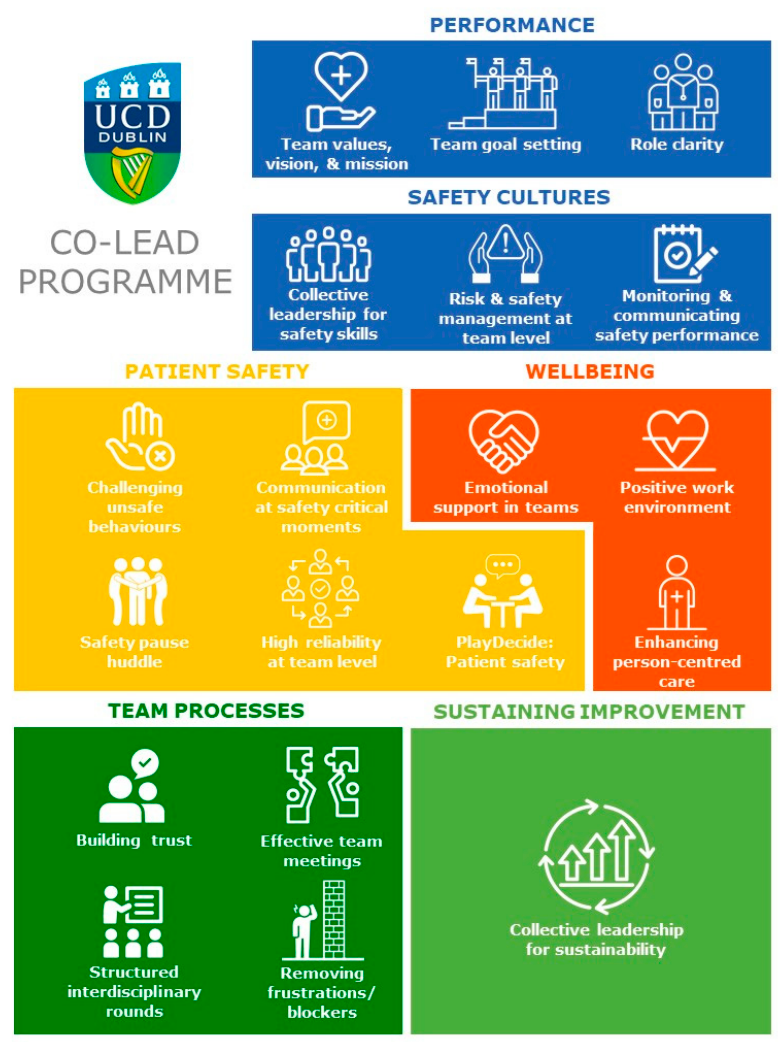
Figure 1. Co-Lead Programme modules.